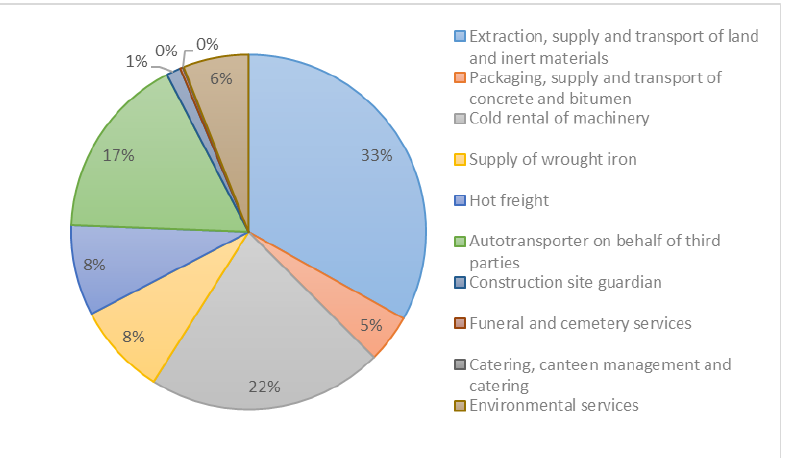
Figure 3. Concentrations of firms (WL) by sector. Source: Authors processing of AIDA Bureau Van Dijk and Prefectures